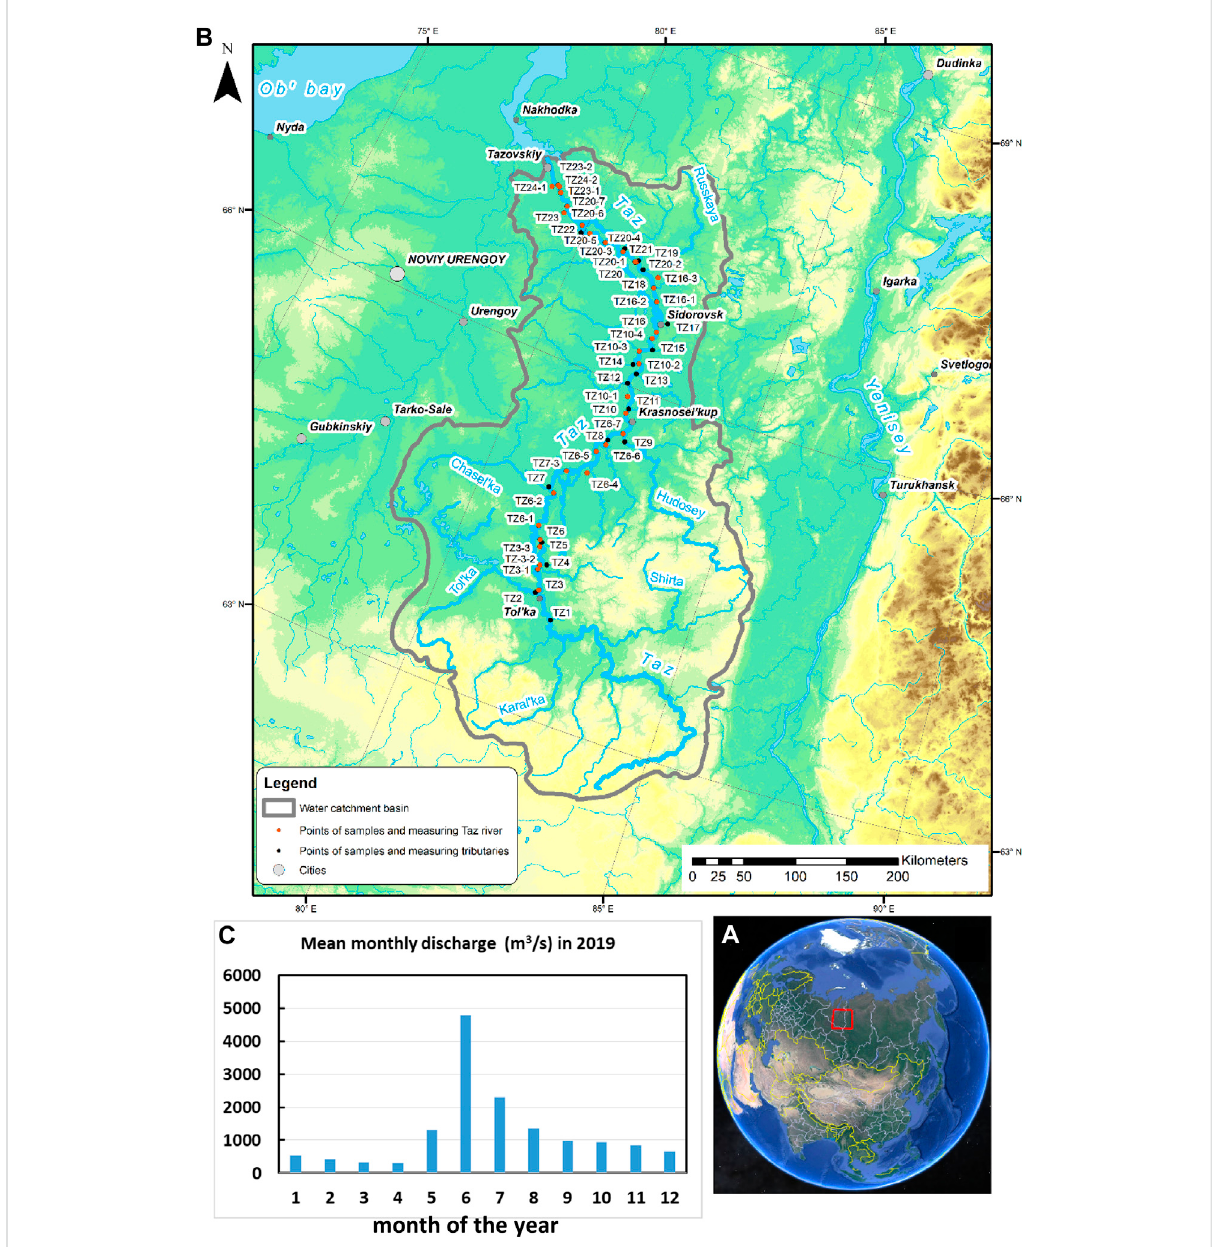
FIGURE 1 Map of the studied Taz River watershed. (A) location of the Taz River basin in the Northern Eurasia; (B) Detailed map of the Taz River and tributaries with sampling points; (C) Monthly discharge (m 3 s − 1 ) at the terminal gauging station (Tazovsky) in 2019. See Supplementary Table S1 for sampling point identi fi